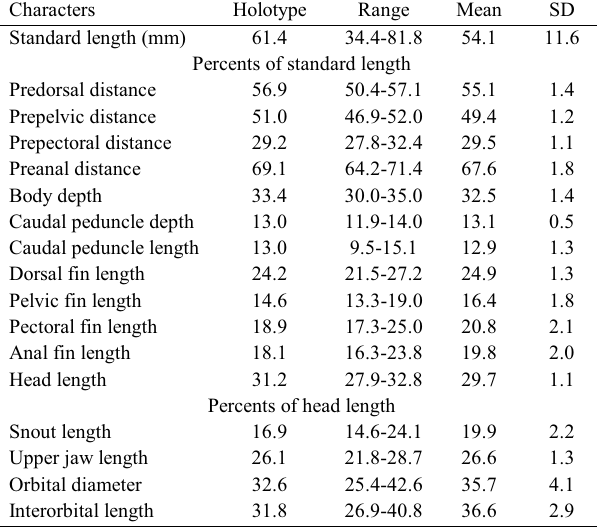
Table 1. Morphometric data of Astyanax totae , based on the holotype (MHNCI 10305) and paratypes (MHNCI 10306, n = 21; MCP 37562, n = 8). SD = standard